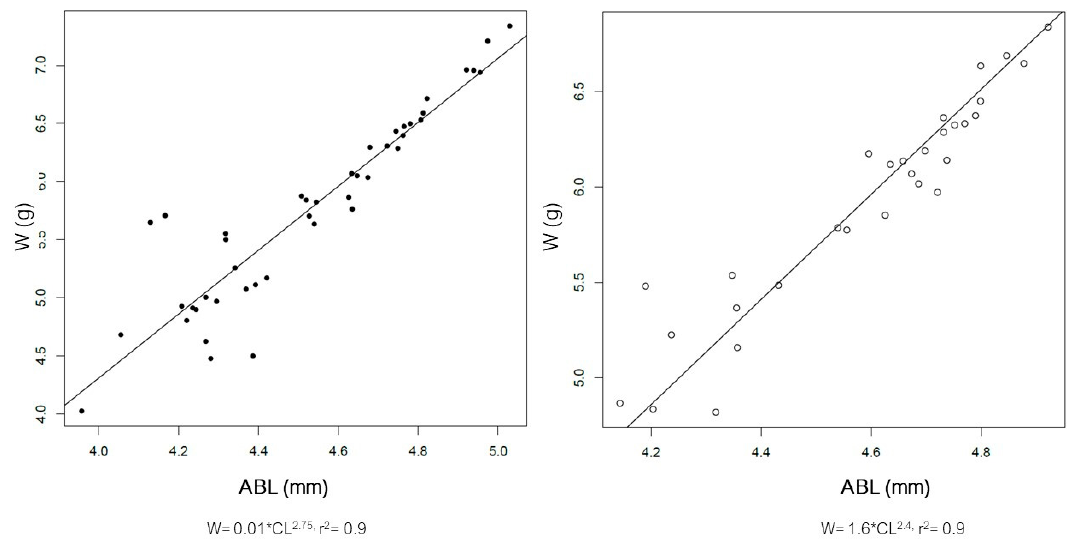
Figure 6. Relationship between abdominal length (ABL) and weight (W) of the male ( left ) and female ( right ) spiny lobsters Panilurus elephas from the Thermaikos Gulf. The linear regression was performed and plotted with R. Data presented after log-transformation.